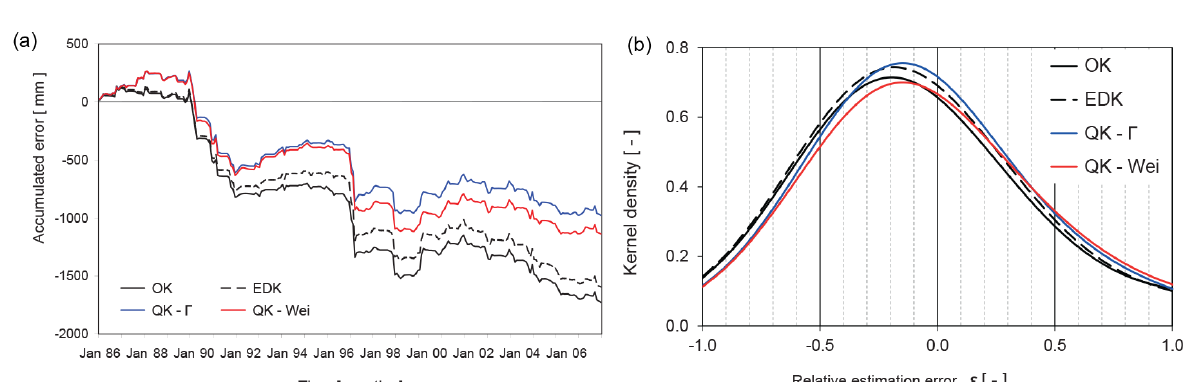
Figure 9. Errors of the estimator Z ∗ ( x 125 ) at raingauge “Wilgervier”: evolution of temporal bias B2 over the study period (a) and smoothed distribution of the relative estimation error (cid:15) r (b)